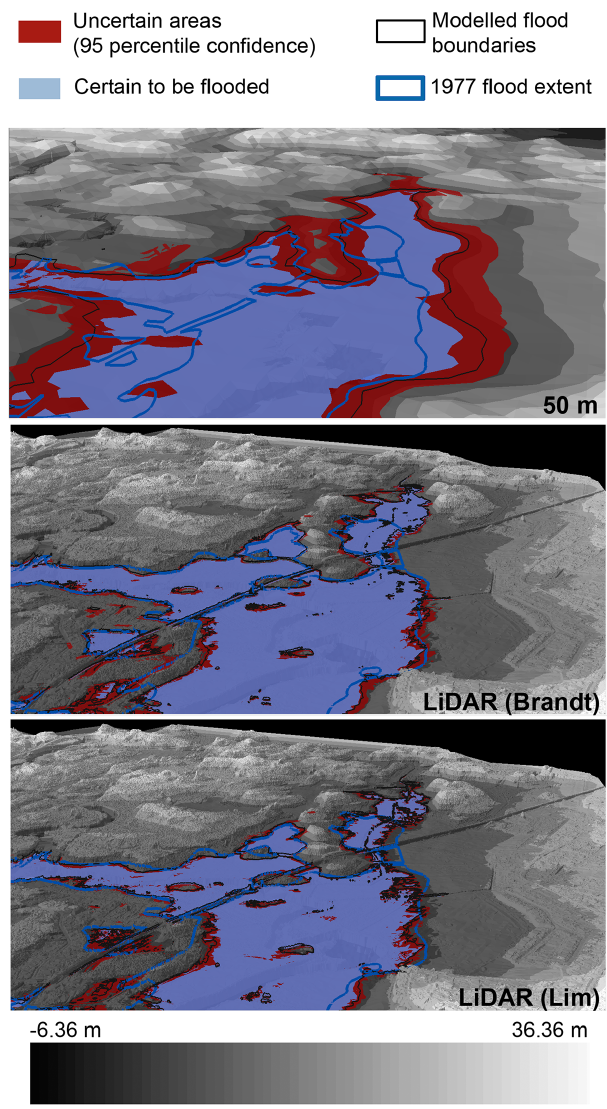
Figure 4. Estimated uncertain and flooded areas using the disparity- distance equation algorithm. Results were based on DEM resolu- tions of 50 and 2.1m (LiDAR).